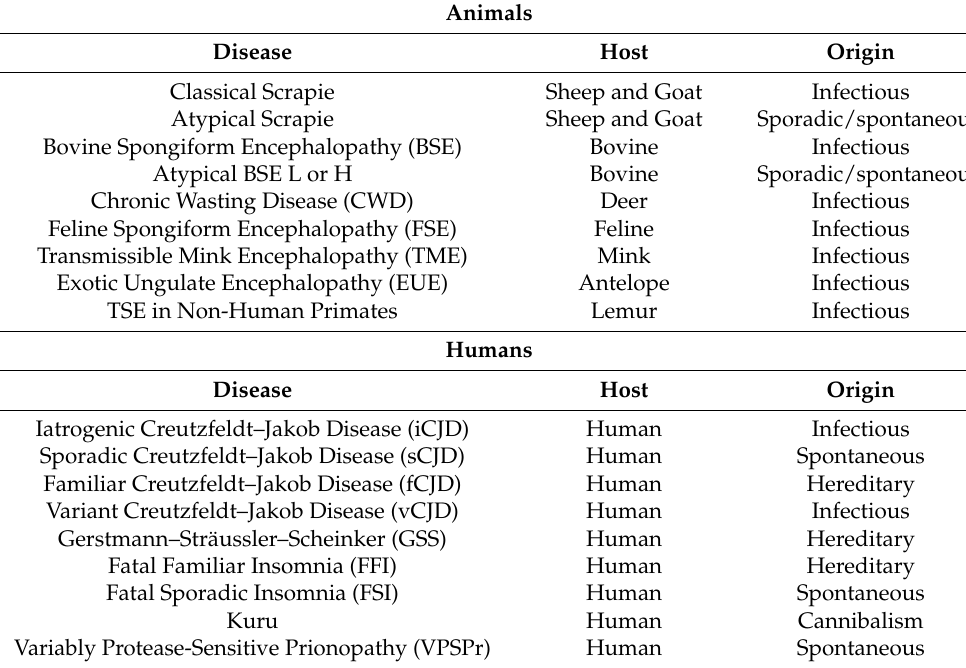
Table 1. Animal and human transmissible spongiform encephalopathies (TSE).